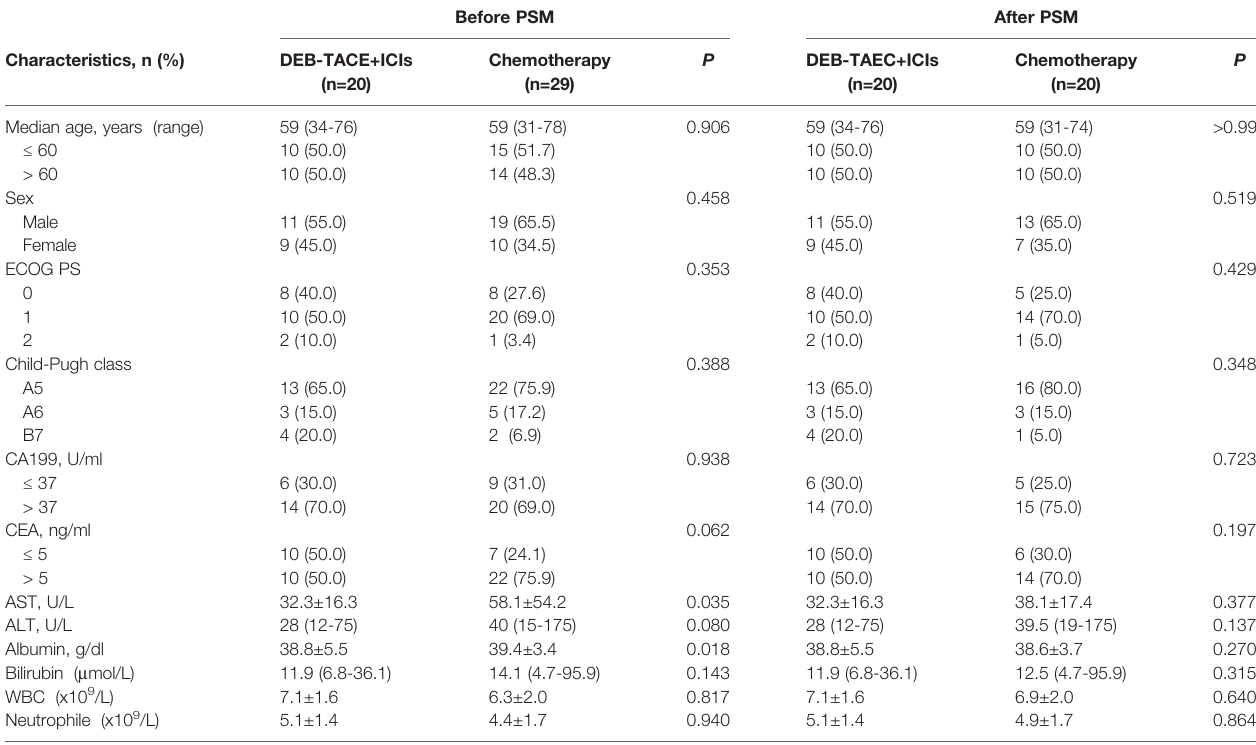
TABLE 1 | Baseline characteristics of patients in the two groups before and after